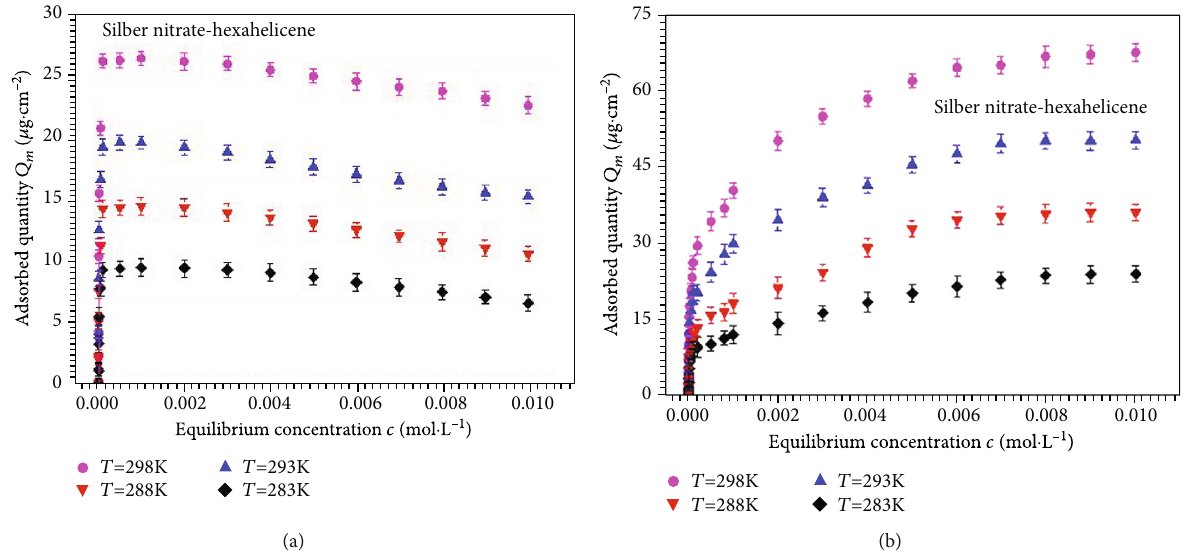
Figure 3: Equilibrium adsorption isotherms of silver nitrate onto hexahelicene and heptahelicene given at four temperatures